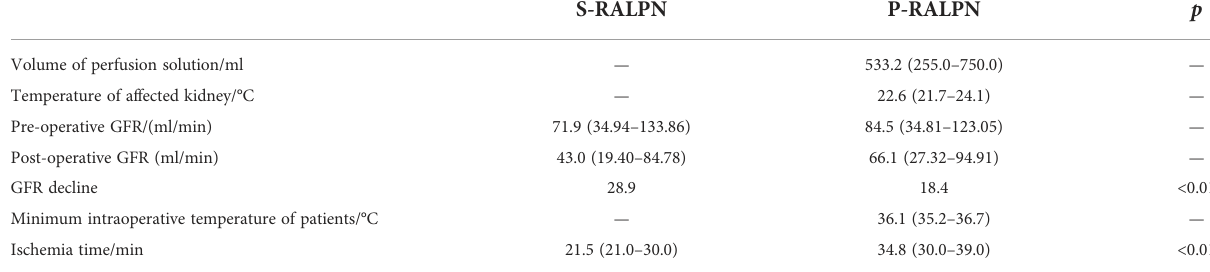
TABLE 3 Intraoperative